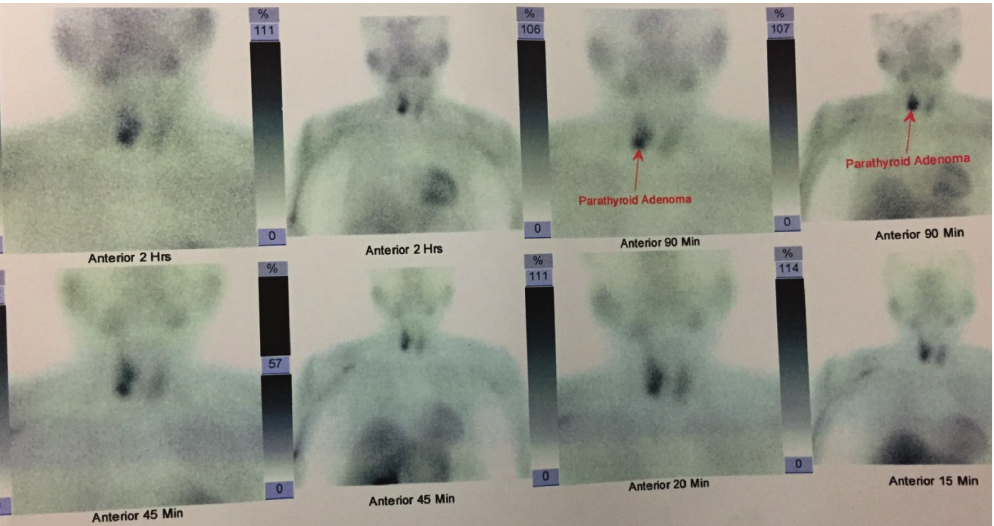
Figure 2: 99m Tc MIBI scan showing right inferior parathyroid adenoma.